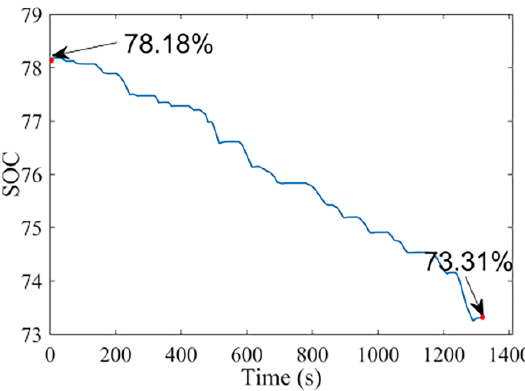
Figure 22. SOC of EC shift schedule. Experiment results of the shift schedule based on RL: